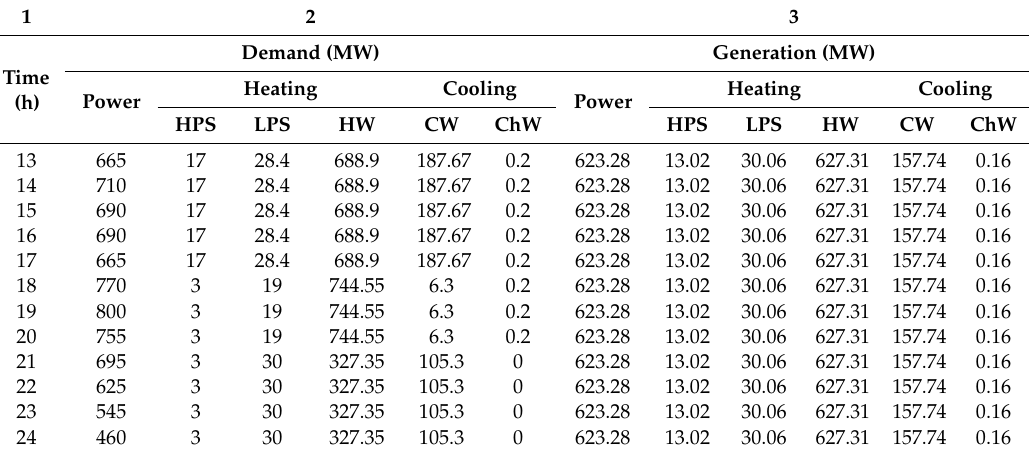
Table A20. TriGenSCA for final trigeneration PWR NPP without integration from time 13 to 24 h.